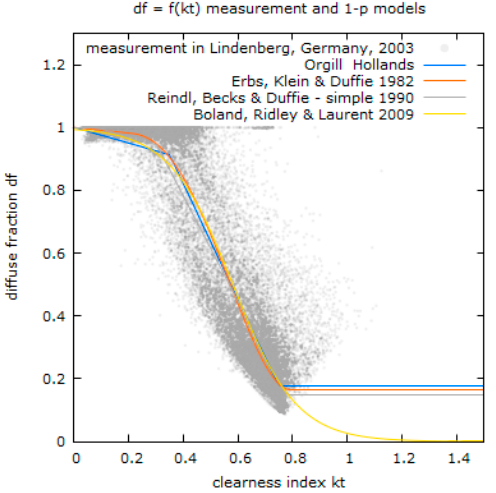
Figure 2. Measured diffuse fraction over clearness index kt for one year of measurement (grey points, extract of 2003) in Lindenberg, Germany. Line plots: Schematic overview of existing one-parameter models. Typically the models define three sections with varying df = f ( kt )